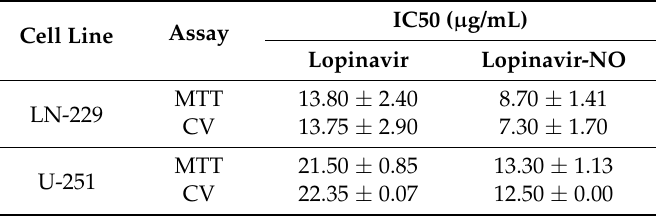
Table 1. IC 50 values of Lopi and Lopi-NO in GBM cell lines. Data are presented as mean ± standard error of the mean (SEM) of three independent